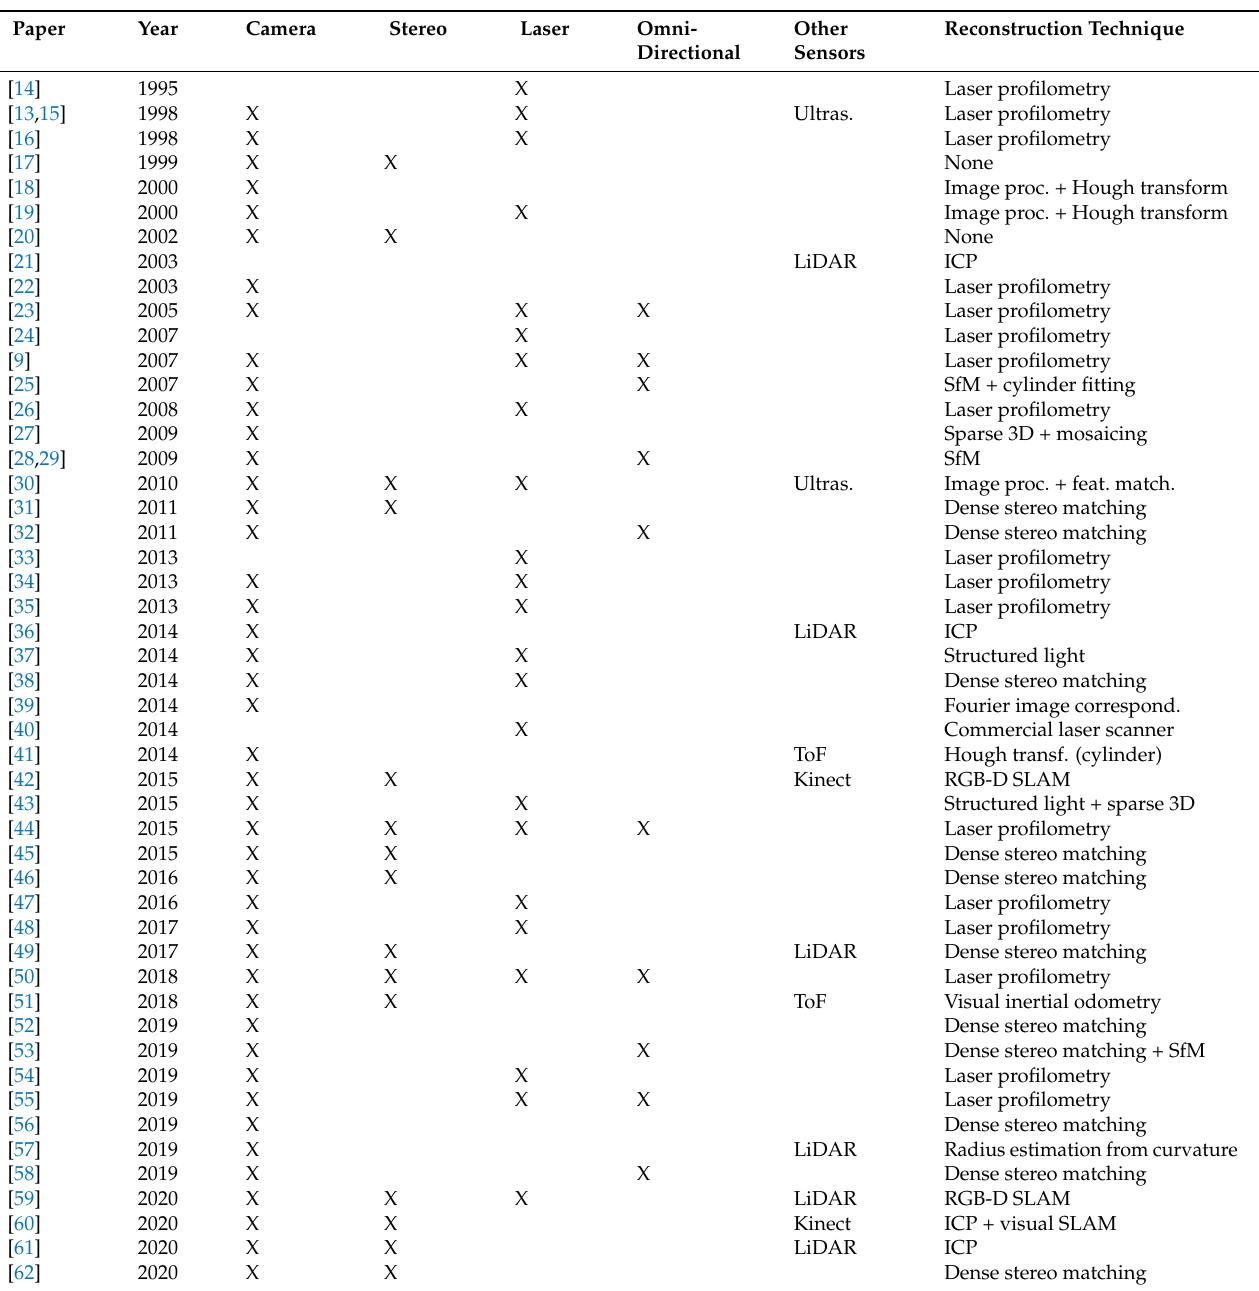
Table 1. Overview of related work on depth sensing technology for internal inspection of sewers or pipe networks. The depth sensing hardware of each paper is categorized into four categories; Camera if the setup contains any camera, Stereo if the setup contains a passive or active stereo setup, Laser if the setup contains a one-dimensional (rotating) laser, and omnidirectional if the setup either contains a catadioptric sensor or a camera with a fish-eye